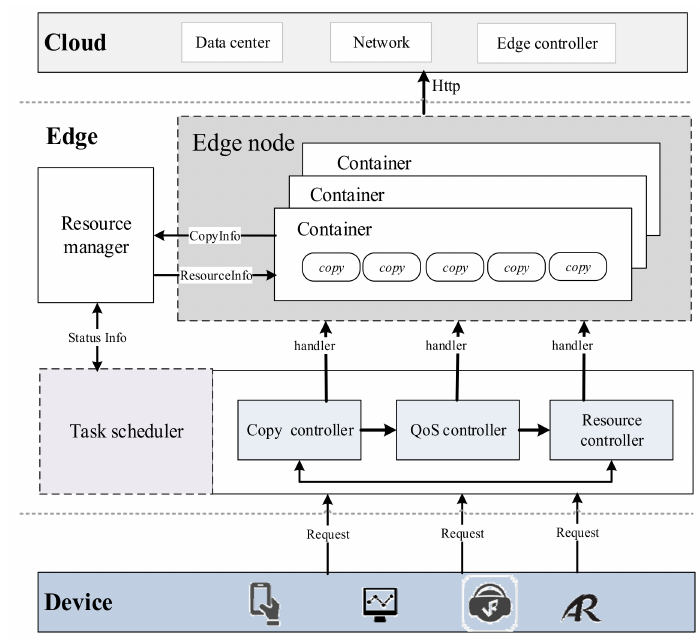
Figure 2. Task scheduling model, where QoS is Quality of